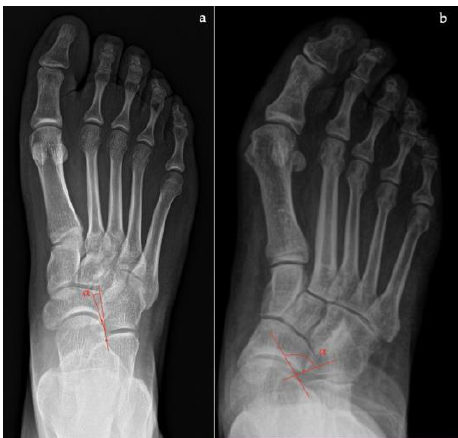
Figure 4. Talar incongruency angle (formed by the intersection between a line from the most lateral point of the articular surfaces of the talus and the navicular, and a line from the lateral aspect of the talar neck (in its most narrow segment) to the lateral point of the talar articular surface). ( a ) Normal foot, 6°; ( b ) pathological flatfoot, >30°.